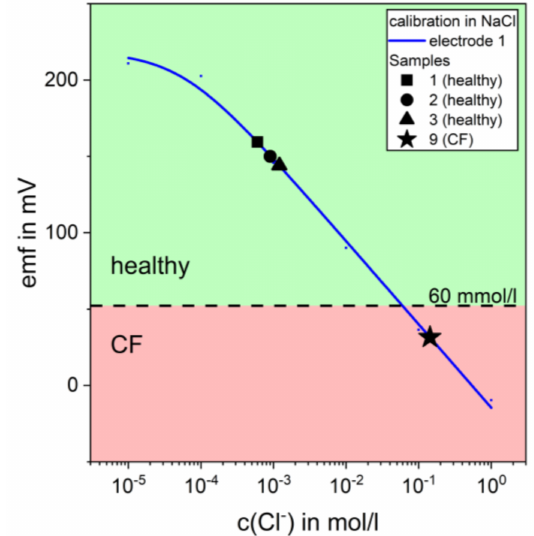
Figure 4. Measurement of sweat samples (samples 1, 2, 3, and 9) using the screen-printed chloride sensor for the detection of cystic fibrosis (CF). The dashed line displays the threshold of chloride concentration. Concentrations > 60 mmol / L indicates CF